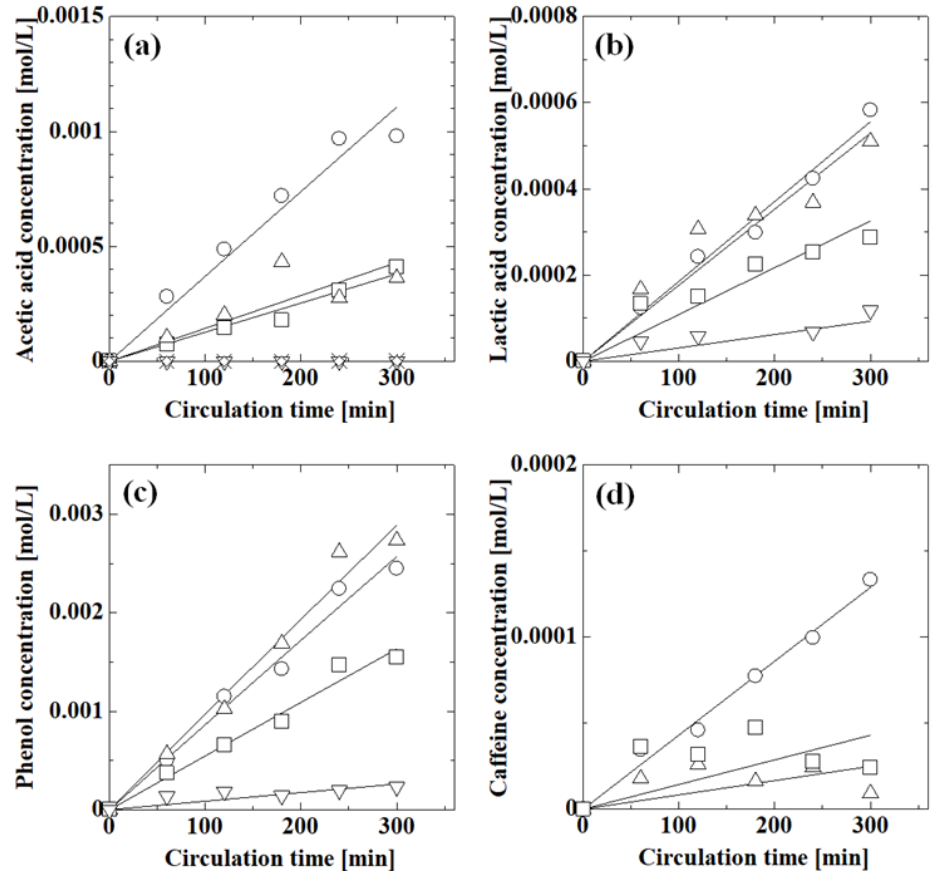
Figure 7. Effect of pH on the permeation of acetic acid, lactic acid, phenol, and caffeine through the PAA-coated alumina membrane obtained with four polymerizations: ( a ) 0.1 mol/L feed concentration of acetic acid at pH 1.2